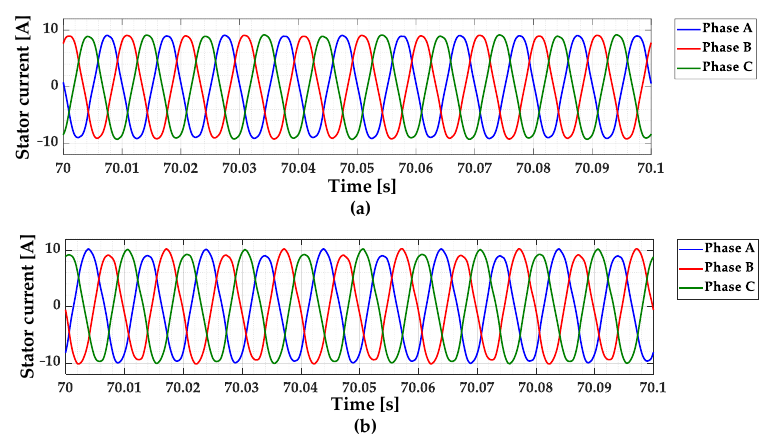
Figure 2. Stator phase current waveforms for ( a ) an undamaged rotor and ( b ) rotor with damaged PMs (partial demagnetization), experimental study ( T L = T N , f s = f sN = 100 Hz).